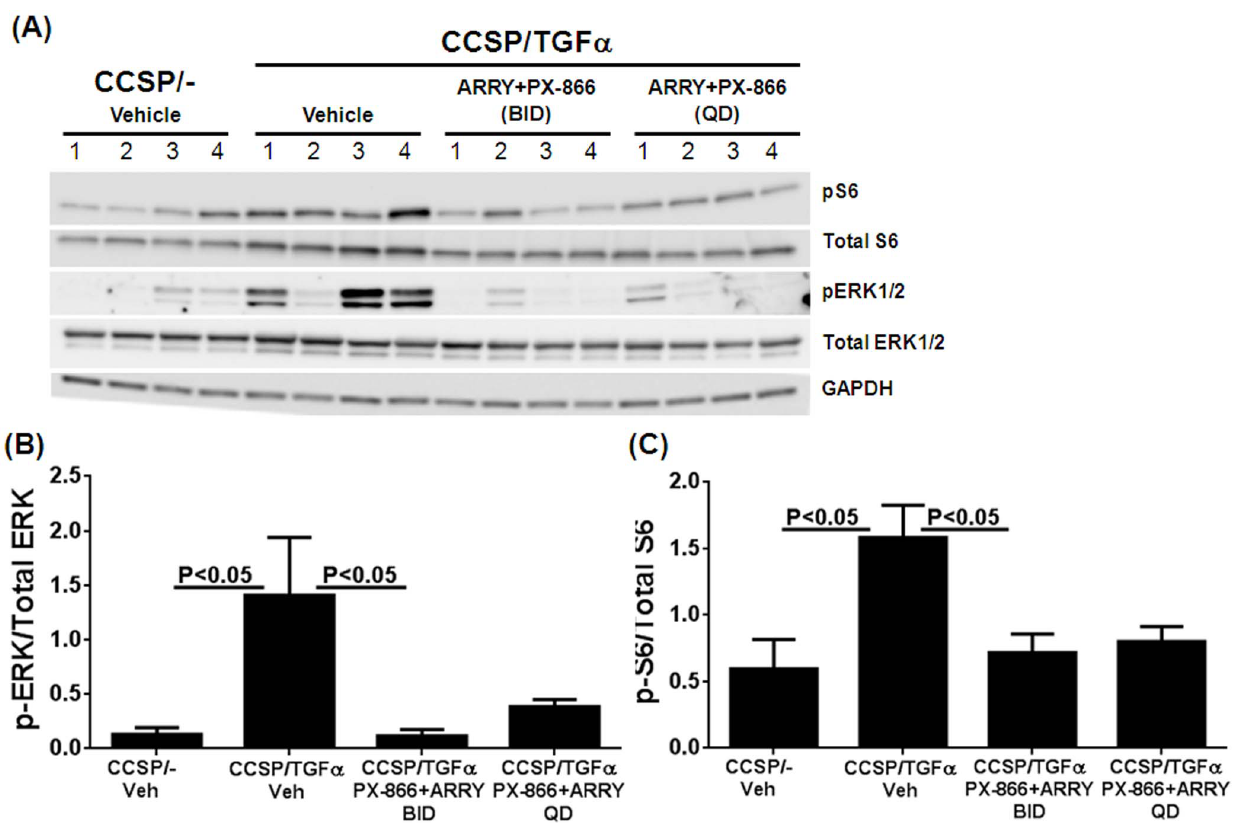
Figure 1. Effect of in vivo inhibition of MEK and PI3K in combination on ERK and S6 phosphorylations. (A) CCSP/ 2 and CCSP/TGFa mice on Dox for 2 weeks were co-treated with PX-866 (3 mg/kg, every other day) and ARRY (37.5 mg/kg) either once a day (QD) or twice a day (BID) for 7 days. Total lung lysates that represent four separate mice in each group were analyzed by immunobloting. Western blot analysis was used to determine levels of phosphorylated ERK (B) and phosphorylated S6 (C) that normalized to the total ERK and S6 protein in lung homogenates, respectively. Data are means 6 SEM, and statistical significance between groups was measured using one-way ANNOVA (n=4/group).